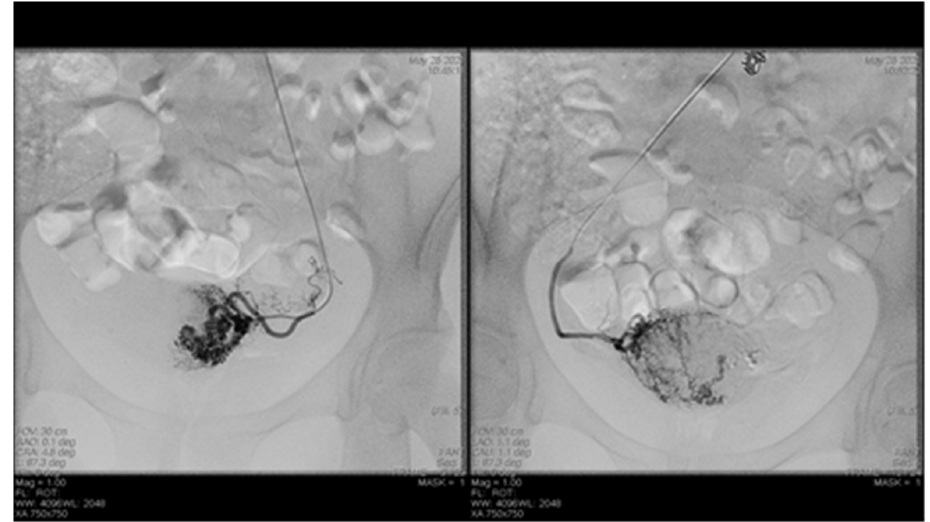
Figure 6. Selective artery embolization in patient with arterial venous malformation.